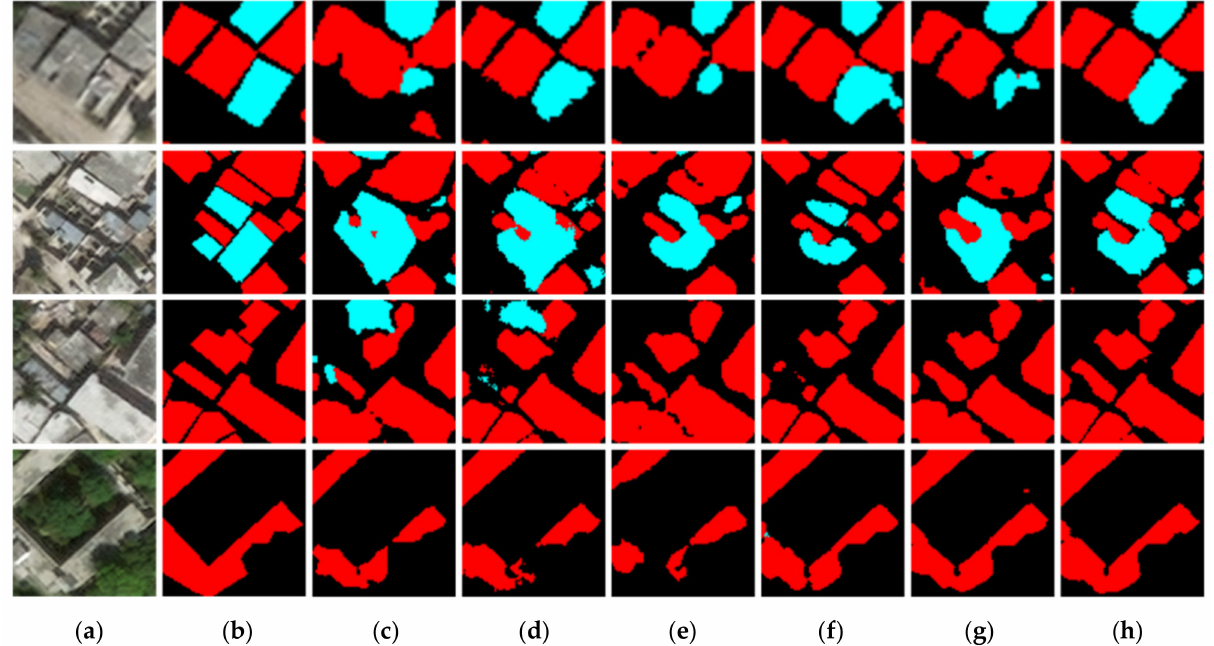
Figure 12. Partially enlarged images of the detection results of the HTI dataset by different networks: ( a ) original image; ( b ) ground truth map; ( c ) DeepLabv3+; ( d ) UNet; ( e ) MobileNetV2+CA; ( f ) UNet 3+; ( g ) OB-DeepLabv3+; ( h ) OB-UNet; red, blue and black in ( b – h ) represent the non-collapsed buildings, collapsed buildings and the